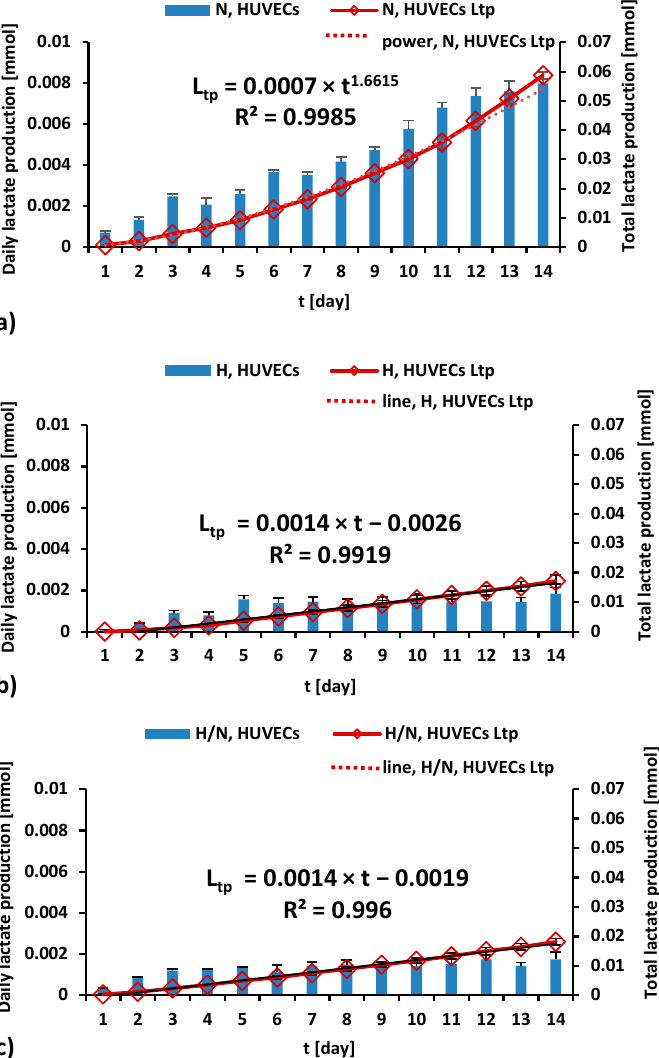
Figure 5. The daily (blue bars) and total (red line) lactate production during a 14-day culture of HUVECs in medium with N ( a ), H ( b ), and H/N ( c ) glucose concentration; L tp —total lactate production.